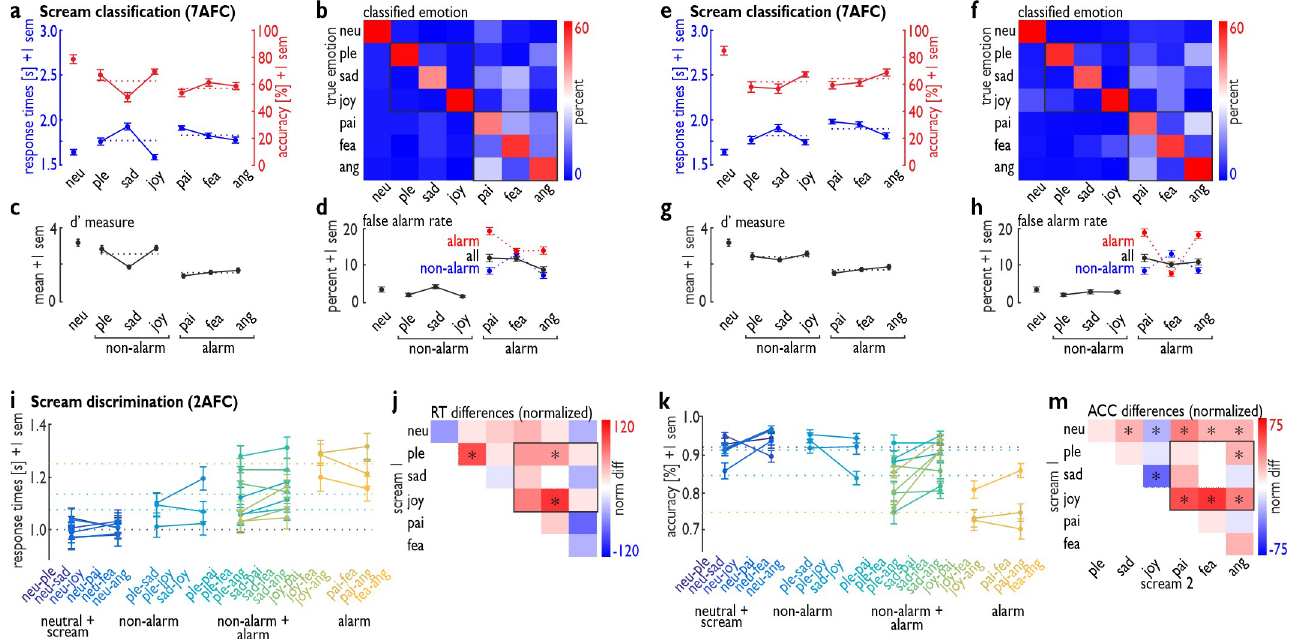
Fig 2. Perceptual decision-making on perceived scream calls. (a–d) RTs and accuracy level for (a) categorizing the 7 types of screams in a 7AFC task (top left) in experiment 2 ( n = 33). (b) During misclassification of screams (top right, off-diagonal), participants significantly used more categories from alarm screams than from non-alarm screams (bottom right). (c) Combining the hit rate and the false alarm rate results in the d 0 measure of sensitivity to detect a certain scream type (bottom left). (d) The false alarm rate is also reported separately for alarm (red) and non-alarm screams (blue). (e–h) The experiment 2 was replicated with an independent sample of n = 29 participants but using a new selection of 84 scream stimuli. The data were analyzed identically to the data reported in (a–d). (i– m) RT (i) and accuracy level (k) for discriminating scream calls (experiment 3, n = 35) from neutral screams (first set), for discriminating non-alarm screams from non-alarm screams (second set), for discriminating alarm screams from non-alarm screams (third set), and for discriminating alarm screams from alarm screams (fourth set). Panels (j) and (m) show the normalized RT and accuracy difference between the 21 combinations of screams. � p < 0.05, based on a non- parametric permutation test. Numerical data underlying the plots (a–m) can be found in S2 Data. 2AFC, 2-alternative forced-choice; 7AFC, 7-alternative forced- choice; ang, anger; fea, fear; neu, neutral; norm diff, normalized difference; pai, pain; ple, pleasure; sad, sadness; sem, standard error of the